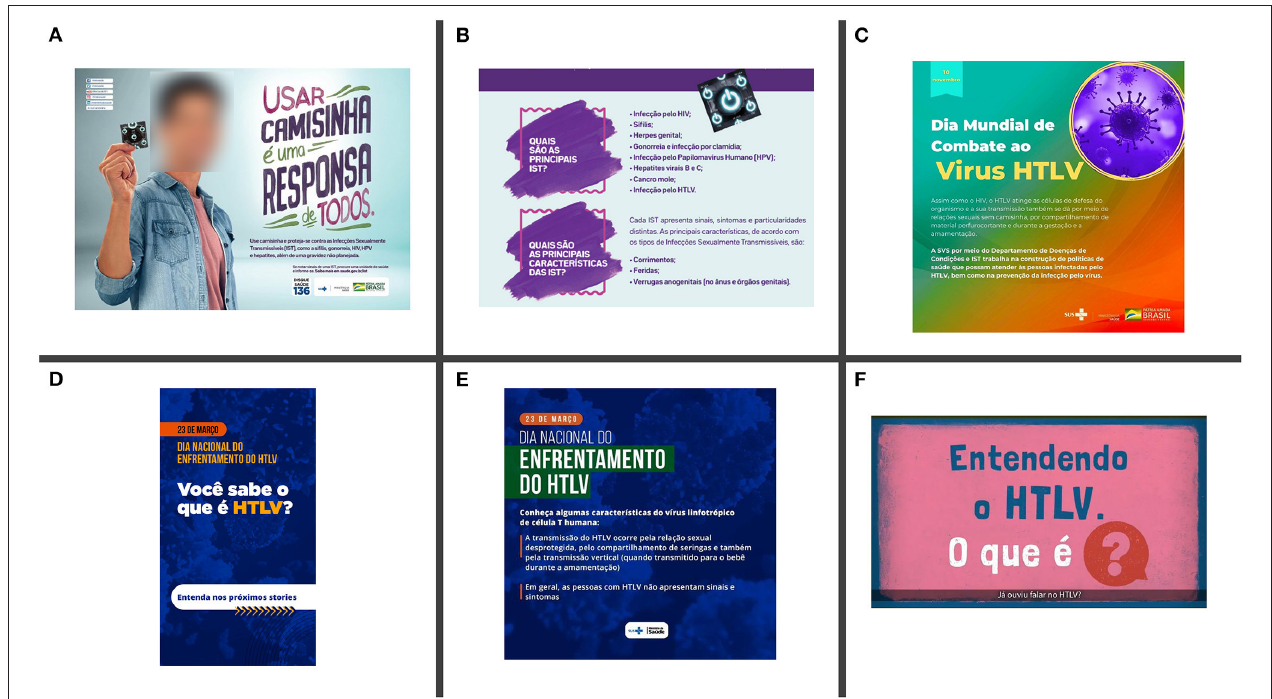
FIGURE 4 | Awareness campaign about HTLV-1/2 promoted by the Brazilian Ministry of Health. (A,B) 2019 awareness campaign; (C) HTLV National day awareness campaign 2020; (D,E) HTLV National day awareness campaign 2021; (F) HTLV World Day awareness campaign